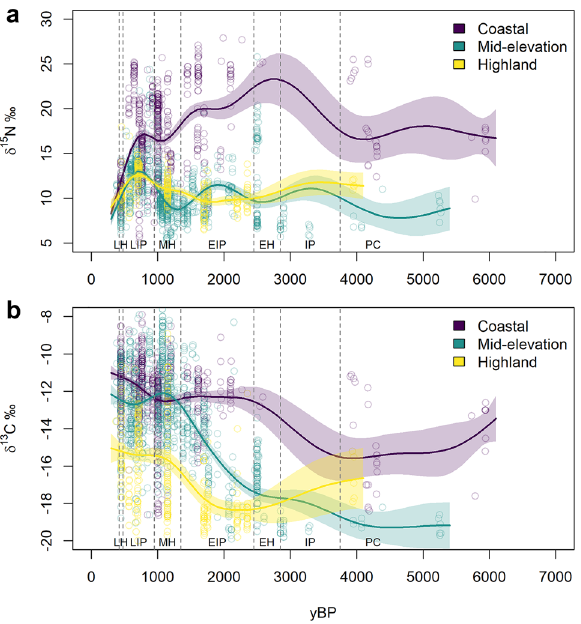
Figure 3. Generalized additive model time series. GAM regression results for both ( a ) δ 15 N‰ and ( b ) δ 13 C‰ across the three elevation categories. Dots represent the observed individuals plotted at their median date determined via resampling of their date range 10,000 times (weighted by calibrated radiocarbon probability for directly dated individuals). Solid lines are the central tendencies for each elevation category with shaded 95% confidence intervals. Lines were generated by creating 10,000 GAMs per elevation zone and isotope (60,000 total) where, for each GAM, each individual received a single year as their date, sampled via weighted sampling of their date range. The central tendency line is the mean fit line of the 10,000 GAMs for each sample, with 95% CIs created from the mean standard error and standard deviation of the 10,000 GAMs for each sample. Time periods follow the chronological periods from Moseley 58 : Preceramic (PC), Initial Period (IP), Early Horizon (EH), Early Intermediate Period (EIP), Middle Horizon (MH), Late Intermediate Period (LIP), Late Horizon (LH). Note: This is a time series only and does not incorporate space. Some of the variation within elevation zones relates to spatial variation which is addressed in the RF analyses.